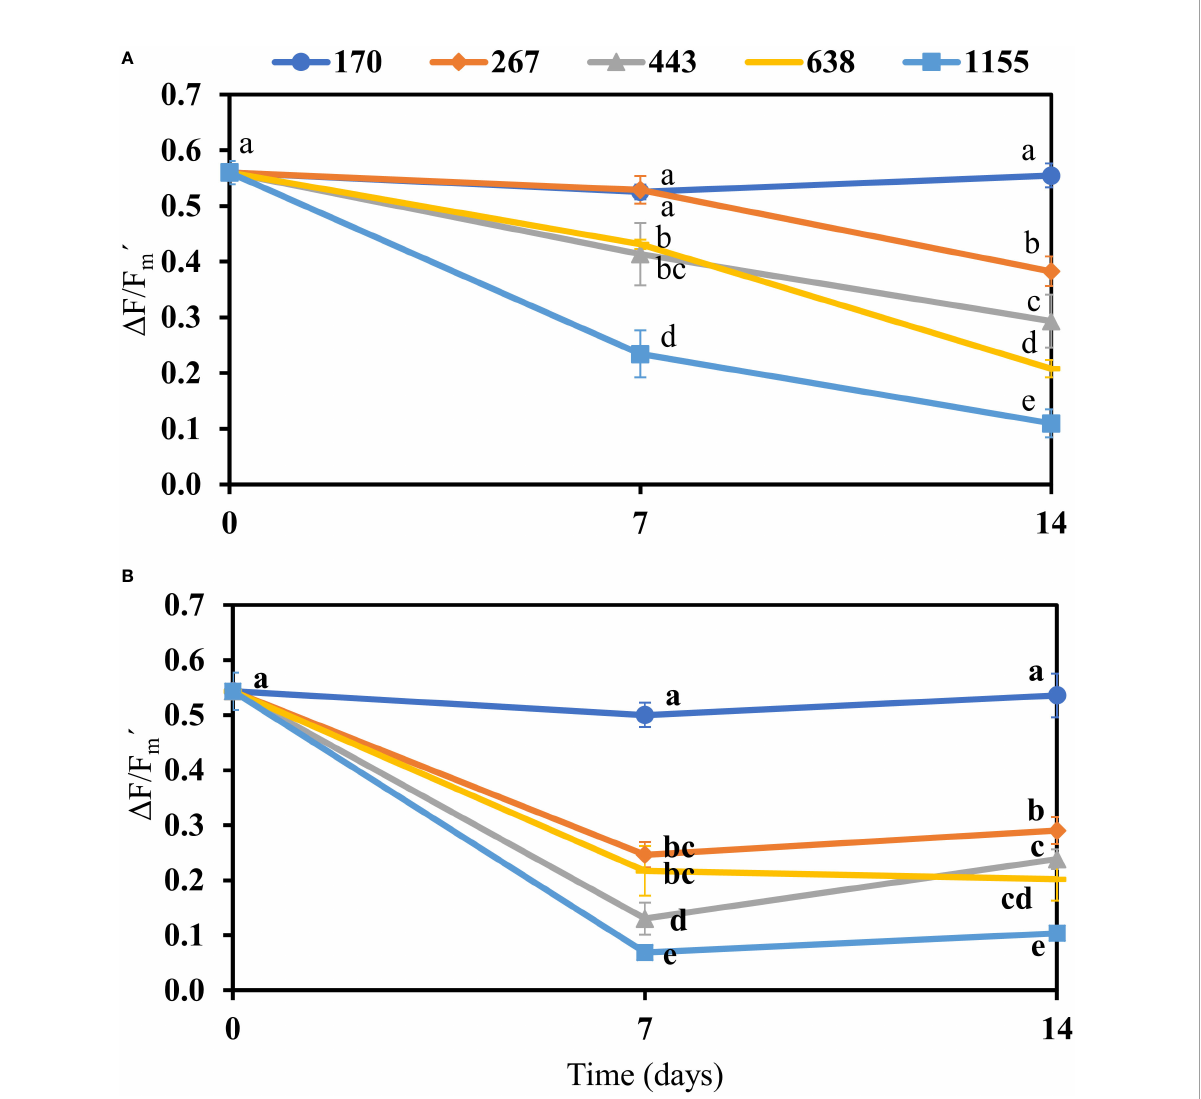
FIGURE 1 Effective quantum yield ( D F/F m ´) in photosystem II of Bostrychia calliptera (A) and B. montagnei (B) cultured under different photon fl ux densities (PFDs: 170, 267, 443, 638, and 1155 µmol photons m – 2 s – 1 ) for 14 days. The effective quantum yield was measured at the beginning of experiment (time = 0) and every seven days. Symbols are means with standard deviations (bars) based on four replicates ( n = 4). Different non-bold and bold letters indicate statistical differences ( p < 0.05) among PFD treatments over time for B. calliptera and B. montagnei , respectively, by three – way repeated measures ANOVA (Table S2) and pairwise